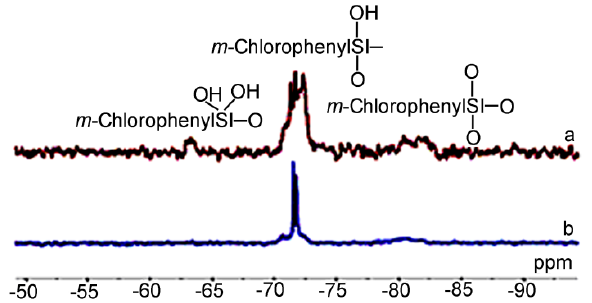
Figure 8. 29 Si NMR spectra of m -chlorophenylcyclosiloxane compounds obtained from the hydrolysis- condensation reaction of 2 conducted at C HCl = 0.056 ( a ) and 0.032 ( b ) mol L −1 for 48 h.